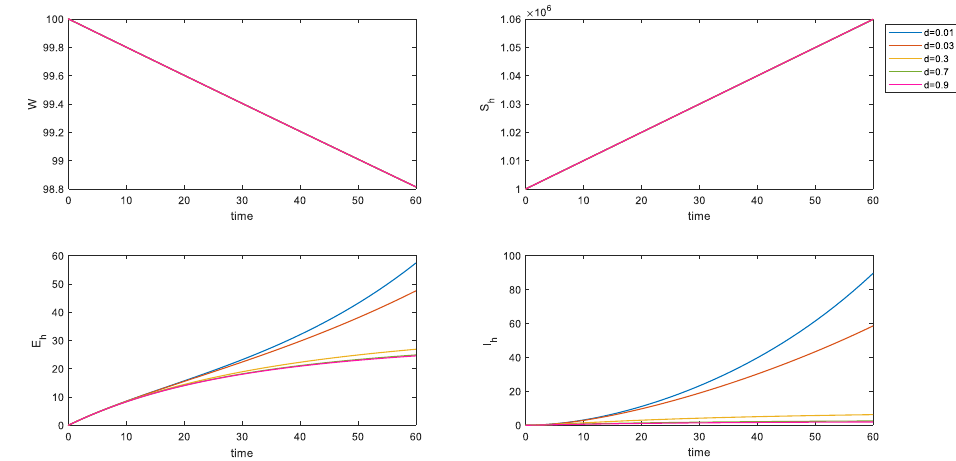
Figure 4. Changes in the number of W , S h , E h , and I h with different d in model 1. Thus, the increase in d mainly indicates an improvement in the diagnosis